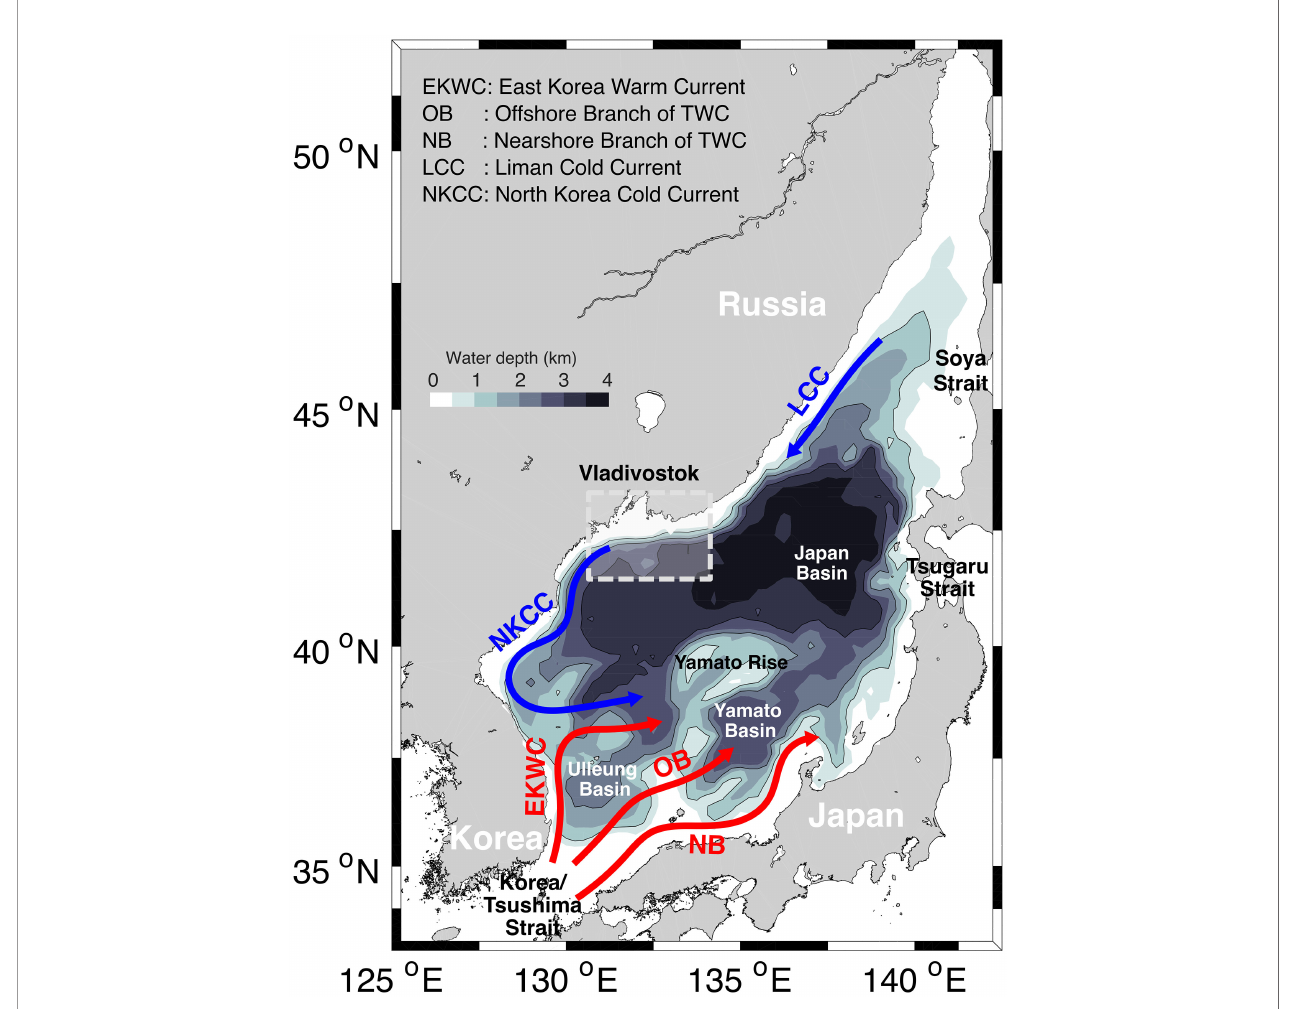
FIGURE 1 | Bathymetry and a schematic major surface currents in the East/Japan Sea. The dashed-box indicates the area where deep convection